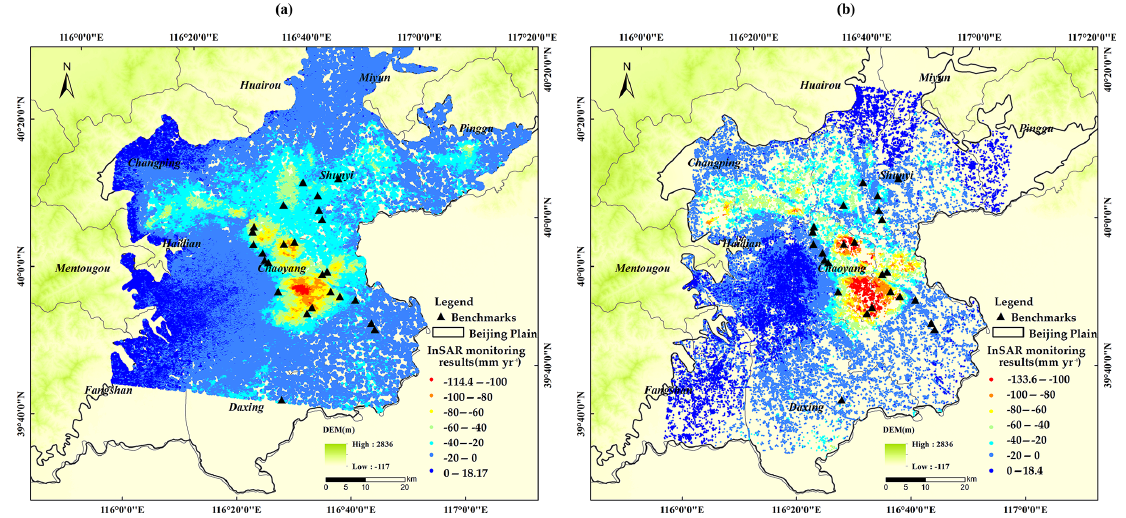
Figure 3. The average land subsidence rate map of the Beijing Plain from 2004 to 2015. Panel (a) is the average rate from 2004 to 2010, and panel (b) is the average rate from 2010 to